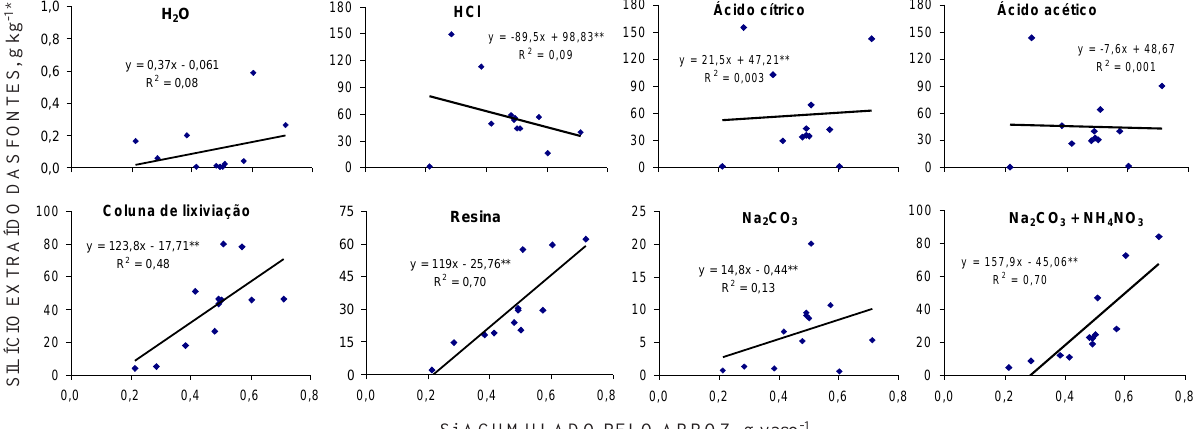
Si ACUMULADO PELO ARROZ, g vaso Figura 3. Correlações entre o Si acumulado pelo arroz e o determinado nas fontes pelos vários extratores utilizados. * O Si extraído das fontes pela coluna de lixiviação é em mg dm -3 ; ** significativo a 1 %.